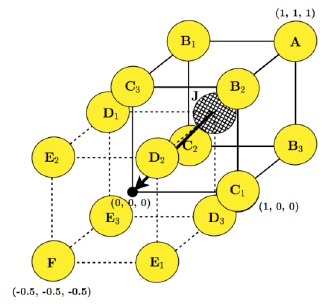
Fig. 1. AKMC simulation box with about 700,000 atoms (1.4% Cu). (left) Initial state with the copper atoms randomly distributed. (right) An intermediate state (after billions of AKMC steps).